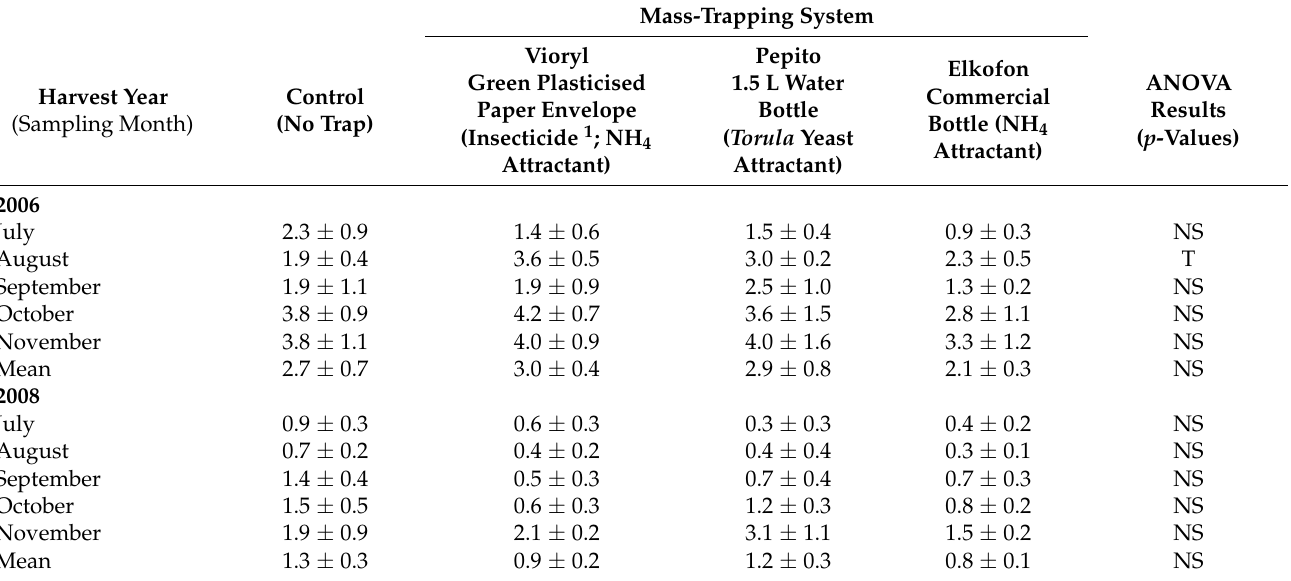
Table 4. Effect of mass-trapping system on olive fly ( Bactrocera oleae ) fruit infestation (% fruit infested) at different times during the growing